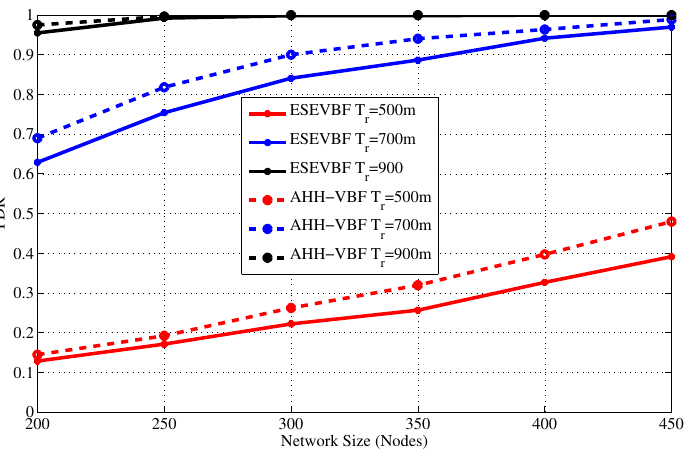
Figure 17. Average packet delivery ratio versus the network size.